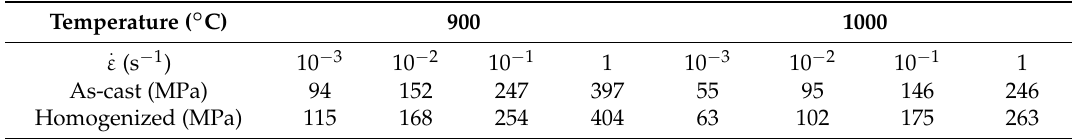
Table 2. The steady state flow stress σ ss ( ε = 0.8) of the as-cast and homogenized alloys at 900 and 1000 ◦ C with strain rates of 10 − 3 –1 s − 1